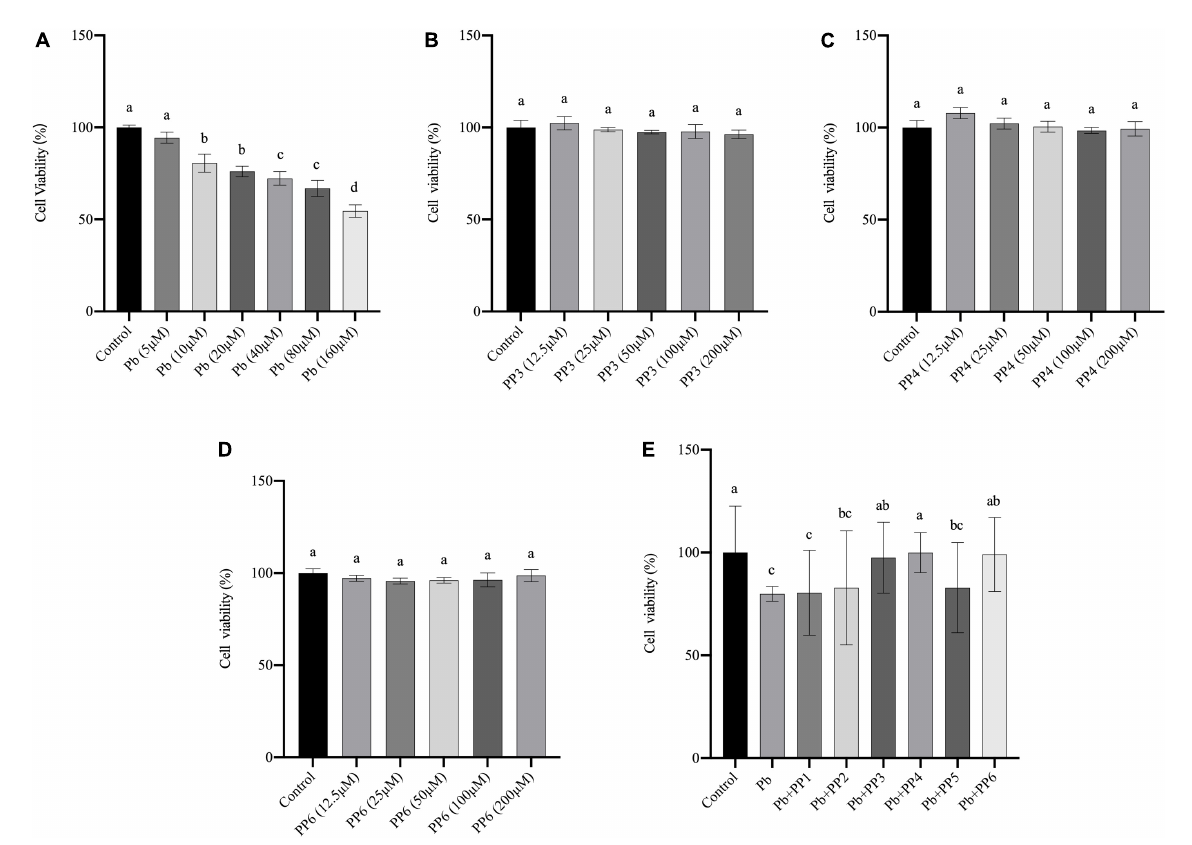
FIGURE1 Effect of different treatments on cell viability of PC12 cells. (A) Effects of lead on cell viability in PC12 cells. PC12 cells incubated with lead (0–160 µ M) for 24 h. (B–D) Effects of PP3, PP4, and PP6 cell viability in PC12 cells. PC12 cells were incubated with (B) PP3, (C) PP4, and (D) PP6 for 4h. (E) Effects of PP1-6 on cell viability in lead-exposure PC12 cells. PC12 cells were pre-incubated with PP1-6 (200 µ M) for 4 h, then treated with 10 µ M lead for 24 h. The valued of the bars indicates the means ± SD ( n = at least 3). Different superscript letters indicate differences ( P <